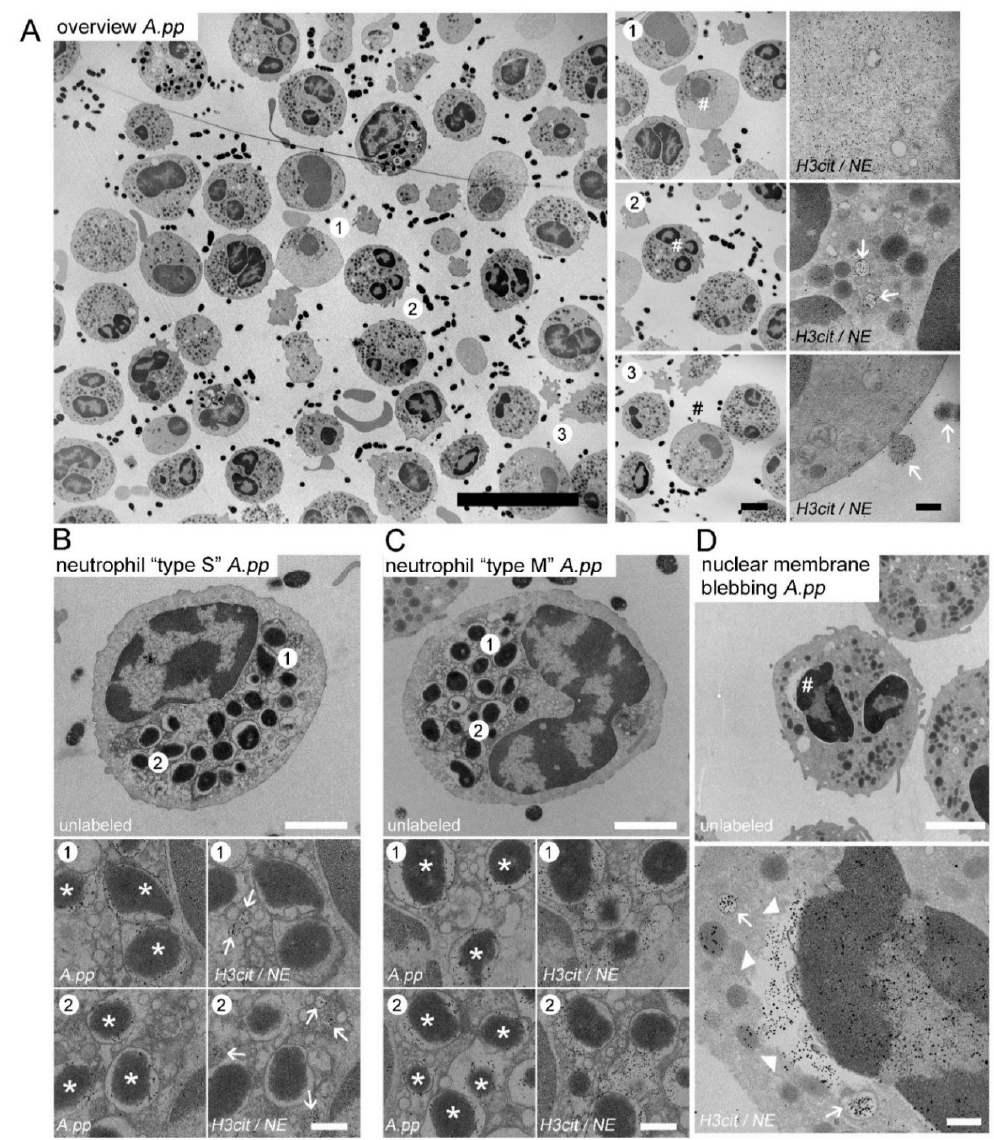
Figure 2. ( A – D ) Representative TEM images derived from one experimental run of porcine neutrophils after 30 min of A.pp infection; ( A ) Overview picture, ( area 1 ) neutrophil containing NE and H3cit in the cytoplasm; ( area 2 ) neutrophil containing NE and H3cit in vesicles (white arrows); ( area 3 ) neutrophil releasing NE and H3cit positive vesicles in the extracellular space (white arrows). The hash marks the zoom area; ( B ) Neutrophil “type separated = type S”: gold-labeling of two serial sections identified neutrophils with phagocytosed A.pp (serial Section 1, left panel, white stars mark A.pp ) and clearly outside all bacteria-containing phagosomes separated NE/H3cit positive vesicles (right panel, white arrows mark vesicles); ( C ) Neutrophil “type merged = type M”: gold-labeling of two serial sections identified neutrophils with phagocytosed A.pp (left panel, white stars mark A.pp ) and these phagosome are in addition NE/H3cit positive (right panel); ( D ) The hash marks in the upper panel the zoom area. Neutrophils after A.pp infection showing nuclear membrane blebbing (NE/H3cit positive gold-labeled, white arrow heads) and vesicles (NE/H3cit, white arrows). Furthermore, NE positive granule and a NE/H3cit positive nucleus were identified; ( A – C ) and (serial Section 1, right panels with zoom pictures) and D lower panel: 5 nm gold labeling = H3-cit and 10 nm gold labeling = NE; ( B , C ) (serial Section 2, left panels with zoom pictures) 10 nm gold labeling = A.pp . Scale bars in A : overview = 10 µm; zoom pictures = 2.5 µm; zoom and gold-labeling = 200 nm; B–D 2 µm (upper panel) and 250 nm (lower panels).